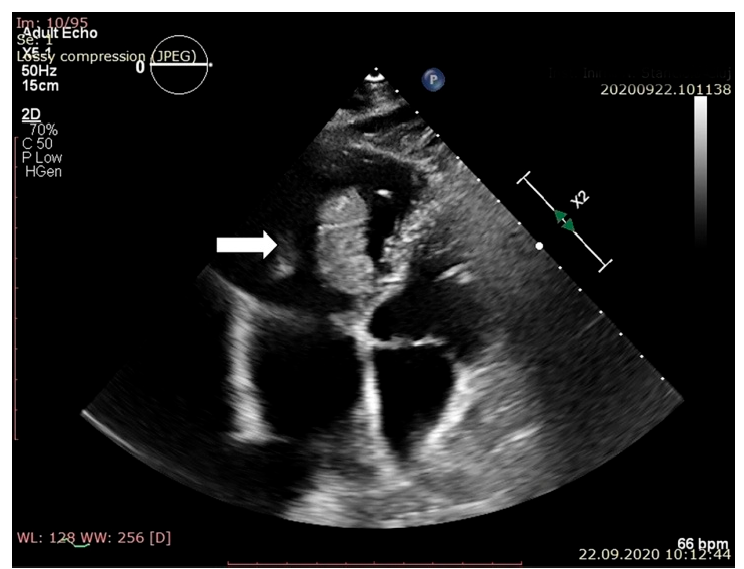
Figure 1. Apical 4 chambers view. Presence of the vegetation in right ventricle in diastole.